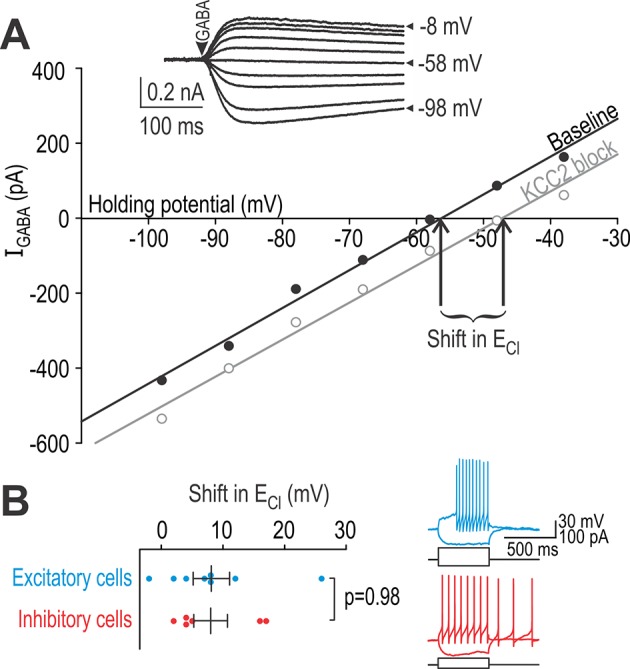
Excitatory and inhibitory neurons have equivalent chloride extrusion capacity.(A) Responses to 5–10 ms-long puffs of 1 mM GABA (arrowhead) were measured in voltage clamp at different holding potentials (inset) in neurons patched with a high-chloride (25 mM) pipette solution. Chloride reversal potential ECl, which corresponds to where the I-V curve intersects the x-axis, was measured before (black) and after (gray) blockade of KCC2 with 15 µM bath-applied VU. The shift in ECl reflects chloride extrusion capacity, which is not equivalent to the change in ECl caused by KCC2 blockade under natural conditions (i.e. without intracellular chloride loading). (B) Neurons identified as excitatory or inhibitory based on spiking pattern (inset) displayed no difference in chloride extrusion capacity (T12 = 0.030, p=0.98; unpaired T-test).Figure 5—source data 1.Numerical values for data plotted in Figure 5.